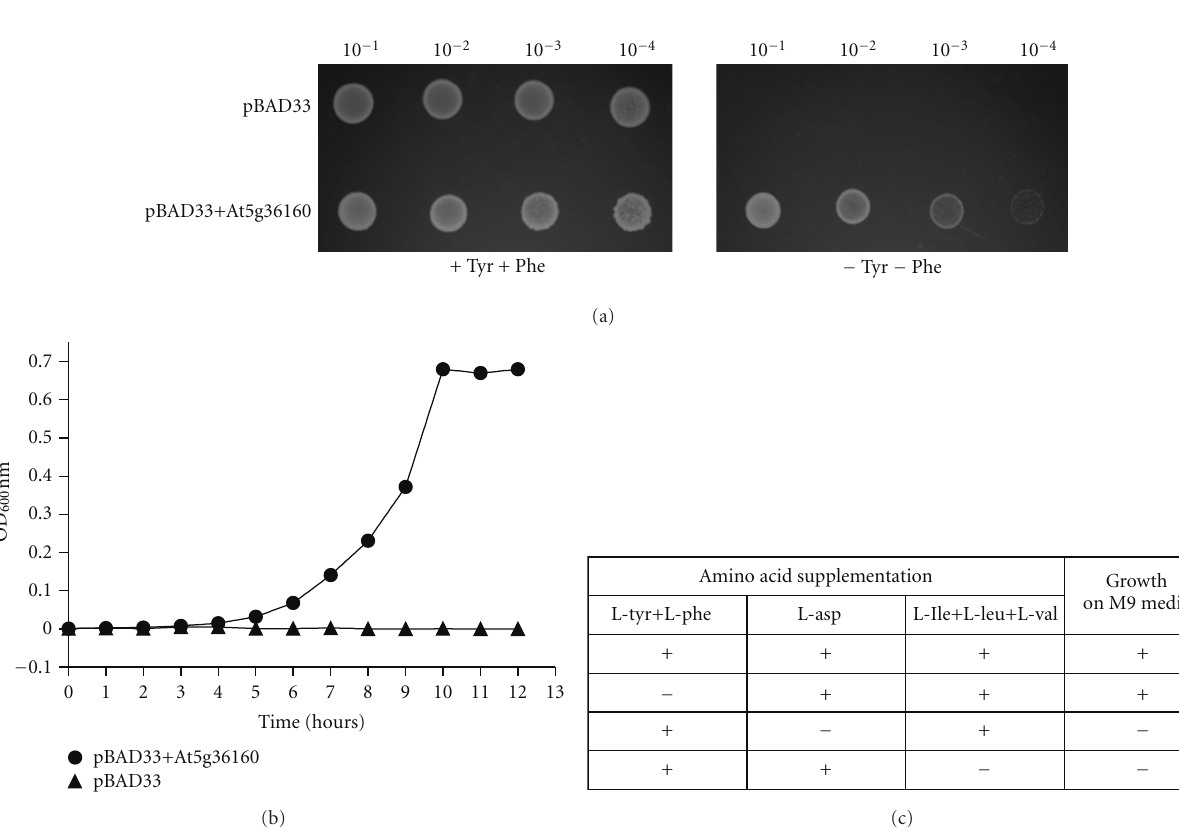
Figure 6: (a) Functional complementation assay. Functional complementation was tested using the E. coli mutant DL39. The plasmids used were pBAD33 and pBAD33+At5g36160. The bacteria were grown to an OD of 1.0 measured at 600 nm, the strains were serially diluted to 10 − 1 , 10 − 2 , 10 − 3 , and 10 − 4 using 0.85% (w/v) saline, and 5 μ L was replica plated on medium with or without L-Tyrosine and L-Phenylalanine supplemented with 0.2% (w/v) arabinose as described in Section 2. It should be noted that 50 individual transformants were replica plated and tested using the complementation assay. All 50 bacteria transformed with the empty vector were unable to grow on media lacking L- Tyrosine or L-Phenylalanine while all 50 transformants expressing the plant enzyme were able to grow on media lacking L-Tyrosine and L-Phenylalanine. For presentation purposes, only one control and one experimental transformant were used in the diagram. (b) shows the growth curve of the DL39 strain transformed with either pBAD33 (triangle) or pBAD33+At5g36160 (circle) in M9 medium lacking L- Tyrosine and L-Phenylalanine supplemented with 0.2% (w/v) arabinose. (c) shows the summary of the functional complementation assay of the plant enzyme ability to complement the E. coli triple mutant on M9 medium.